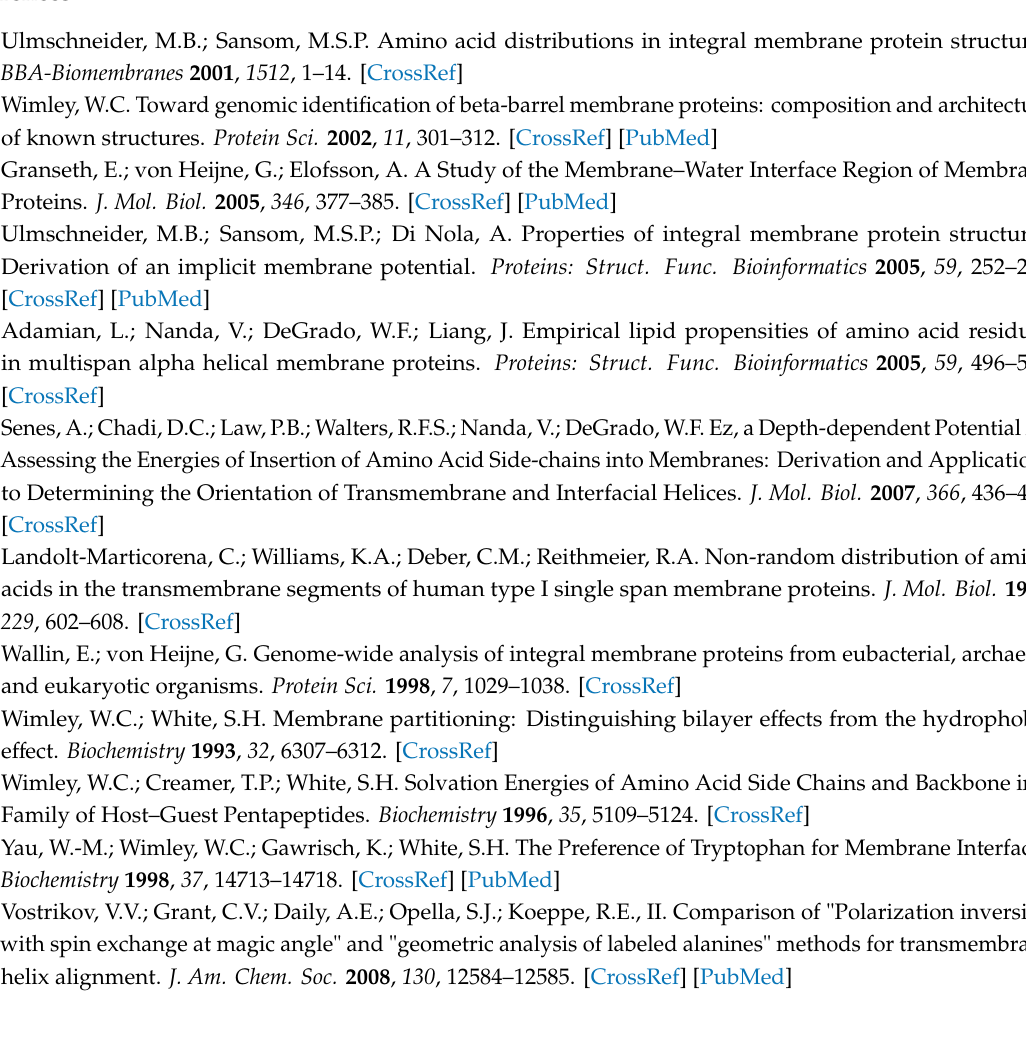
Figure S1: MALDI mass spectra of synthesized H 2,22 WALP23, H 2 GWALP23 and H 22 GWALP23, Figure S2: MALDI mass spectra of synthesized GH 5,19 ALP; H 5 GWALP and H 19 GWALP, Figure S3: Circular Dichroism spectra of H 2,22 WALP23; H 2 GWALP23, and H 22 GWALP23 helices in DLPC lipid vesicles, Figure S4: Circular Dichroism spectra of H 5 GWALP23, H 19 GWALP23 and GH 5,19 ALP23 in DOPC lipid vesicles, Figure S5: 31 P NMR spectra of H 2,22 WALP23, H 2 GWALP23 and H 22 GWALP23 in DLPC lipid bilayers Figure S6: 31P NMR spectra of GWALP23 like peptides with tryptophan to histidine replacements in DOPC lipid bilayers, Figure S7: 2 H NMR spectra of H 2,22 WALP23, H 2 GWALP23, H 22 GWALP23 in DLPC lipid bilayer, Figure S8: 2 H NMR spectra of labeled core alanines of H 5 GWALP23, H 19 GWALP23 and GH 5,19 ALP23 in DOPC lipid bilayers, Figure S9: Selected 2 H NMR spectra to show the pH dependence of resonances for labeled A7 and A9 of H 5 GWALP23 in DOPC lipid bilayers, Figure S10: Selected 2 H NMR spectra to show the pH dependence of resonances for labeled A7 and A9 of H 19 GWALP23 in DOPC lipid